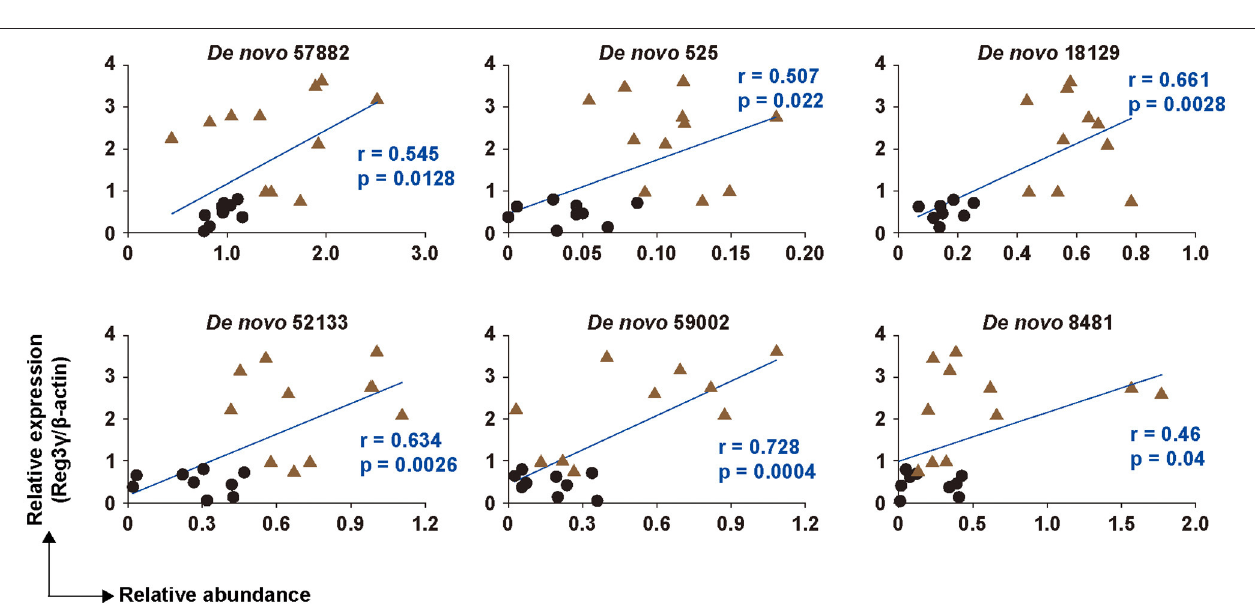
FIGURE 4 | Correlation between six OTUs and the production of Reg3 γ in cecal tissue. The correlation between the production of Reg3 γ and the abundance of De Novo 57,882, 525, 18,129, 52,133, 59,002, and 8,481 ( n = 6–12). The correlation was assessed by Pearson’s correlation coefficient. p indicates the p -value. Statistical analysis was performed after the omission of